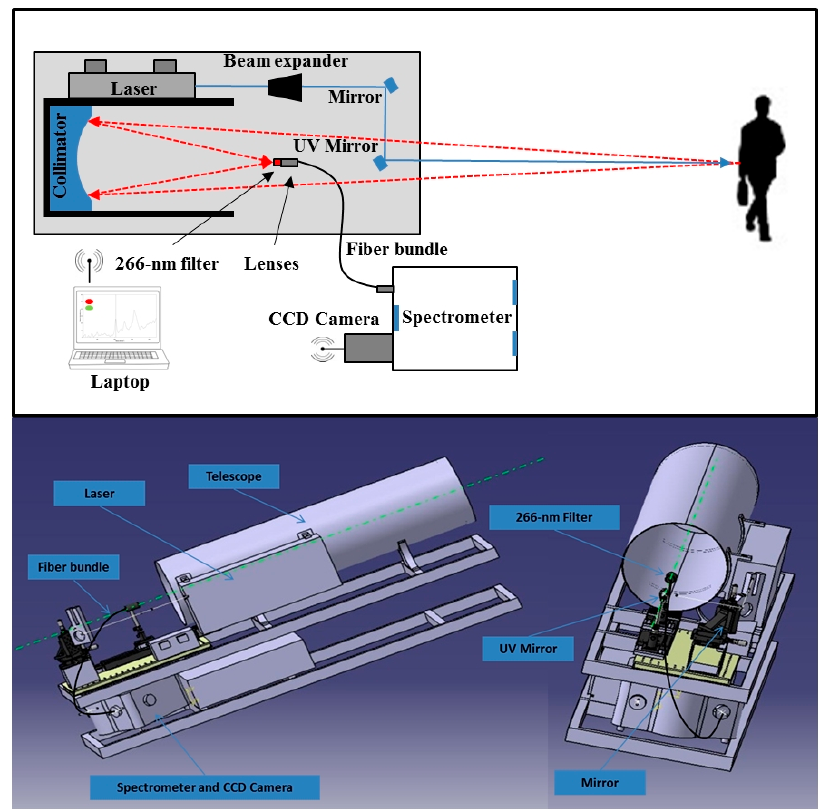
Figure 2. The schematic representation ( above ) and the 3-D model ( below ) of the RADEX system. A single eye-safe laser beam is sent to a target (cloths, backpacks) then, the Raman scattered radiation emitted by the target is collected by a telescope and imaged into the entrance of a Raman spectrometer. At the end, the apparatus provides a spectrum suitable for the explosive detection and identification.